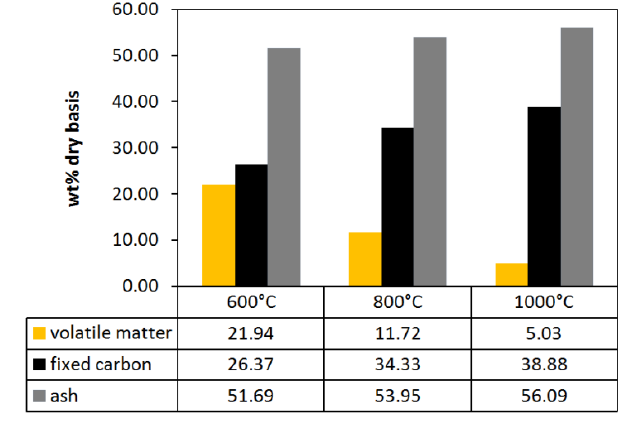
Figure 4. Characterization of rice husk char produced at each temperature (wt% dry